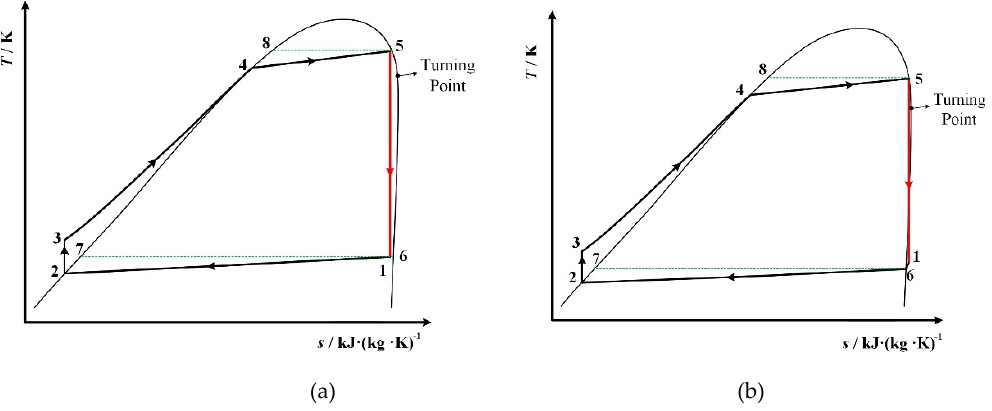
Figure 5. Subcritical ORC using single screw expander with isentropic zeotropic mixture as working fluid: ( a )expander outlet at vapor-liquid two-phase region for R436A; ( b )expander outlet at superheated region. for R436B.